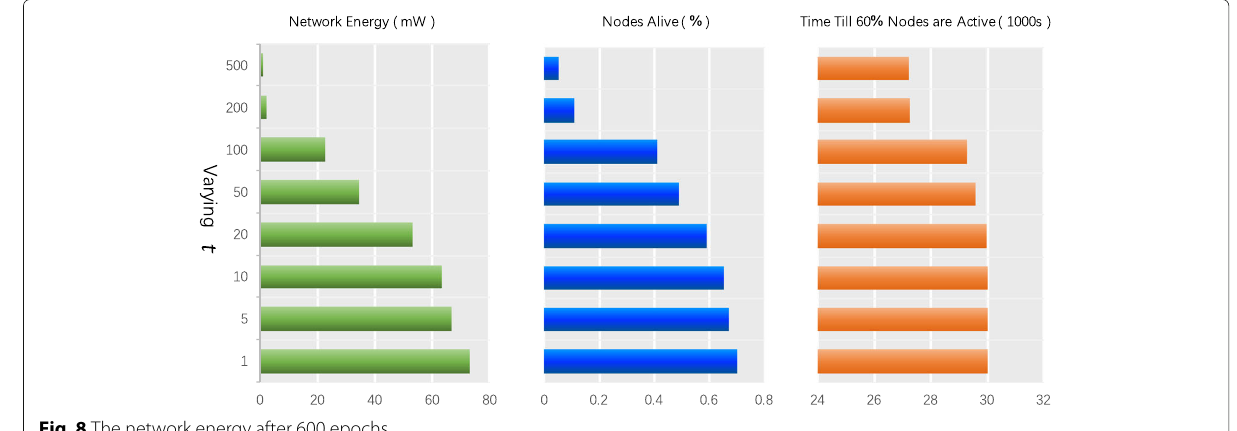
in CWSNs. Each sensor arrives at its choice indepen- dently, by picking a state, jointly defined by spectrum and power based on its local observations. Our method is scal- able and takes the first steps towards making a case for reinforcement learning techniques in sensor